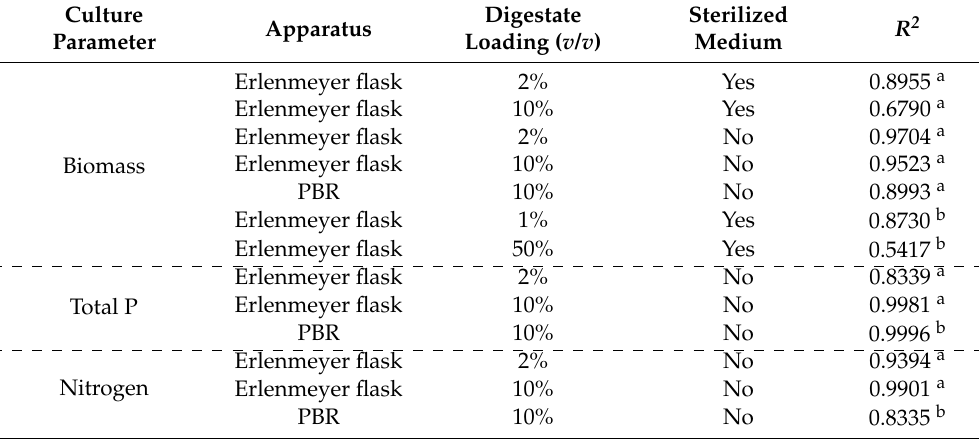
Figure 4. Experimental data and model simulation for ammonia nitrogen removal during growth of the microalgae P. kessleri species in 2% and 10% ( v / v ) non-sterile digested agro-industrial waste ( a ) and in 10% ( v / v ) non-sterile effluent in a photobioreactor ( b ). Table 3. Coefficient of determination values (R 2 ) after optimization or simulation of the model describing the cultivation of P. kessleri in anaerobic digestion effluent.